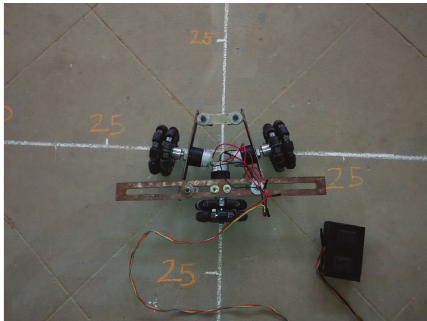
Figure 4: Prototype of TWOMR.